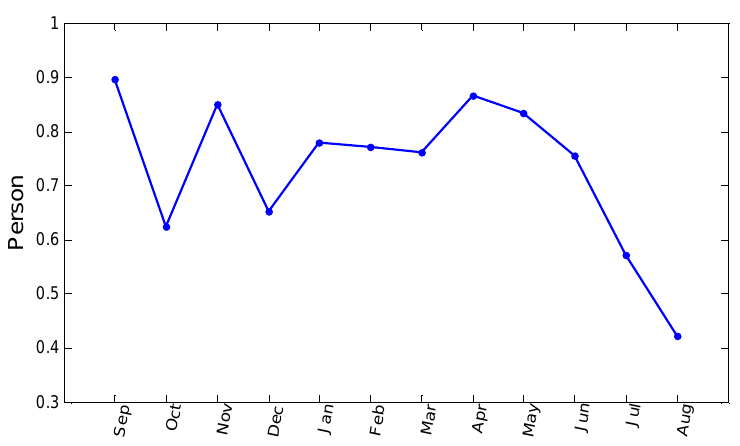
Figure 5. Average correlation coefficient of each month of the time series.